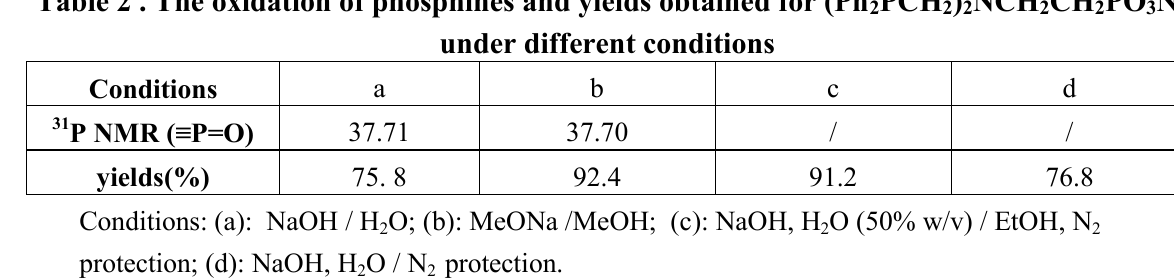
PCH ) NCH CH PO Na 2 2 2 2 2 3 2